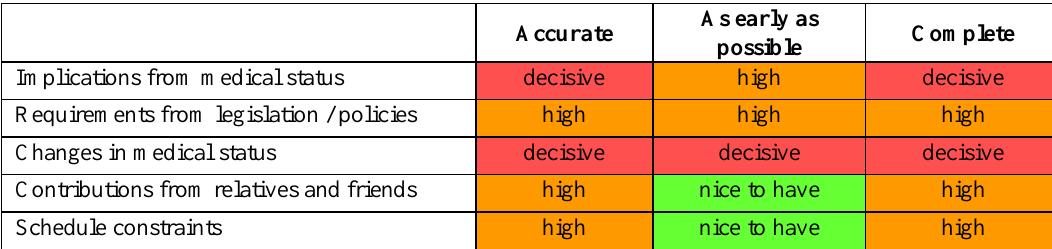
Table 2. Quality criteria for example